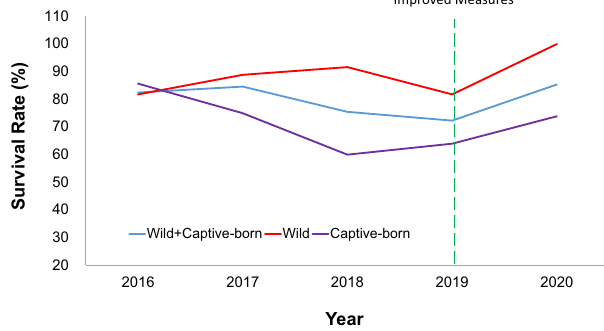
Fig. 2 Annual survival rate of wild and captive-born Malayan pangolins ( M. javanica ) from 2016 to 2020. The green dotted line indicates the time when we implemented strict measures to improve the survival rates of pangolins in